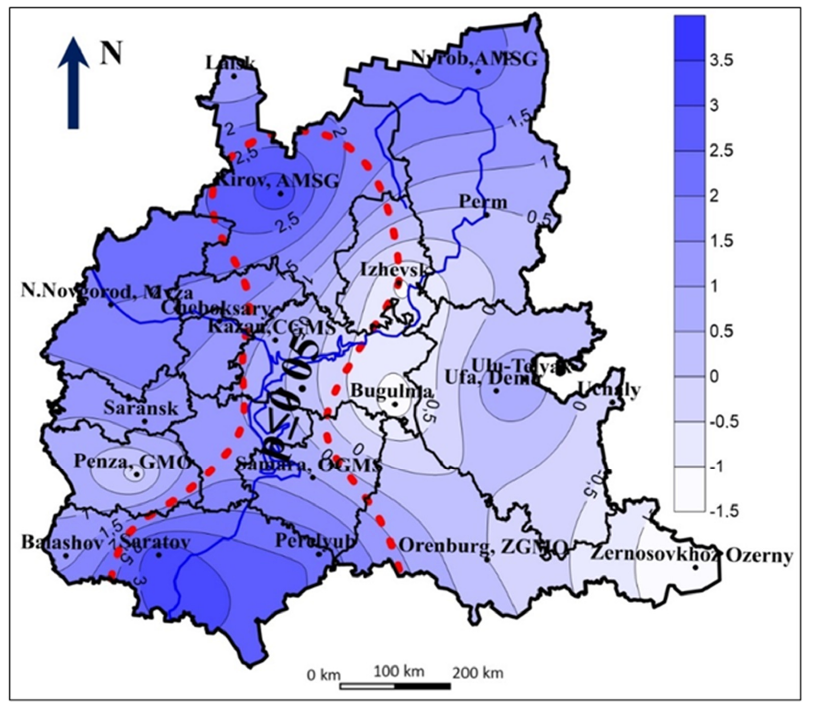
Figure A3. Linear trend slope coefficients (LTSC, mm/10 years) of January precipitation and their statistical significance in the Volga Federal District during 1966–2021.